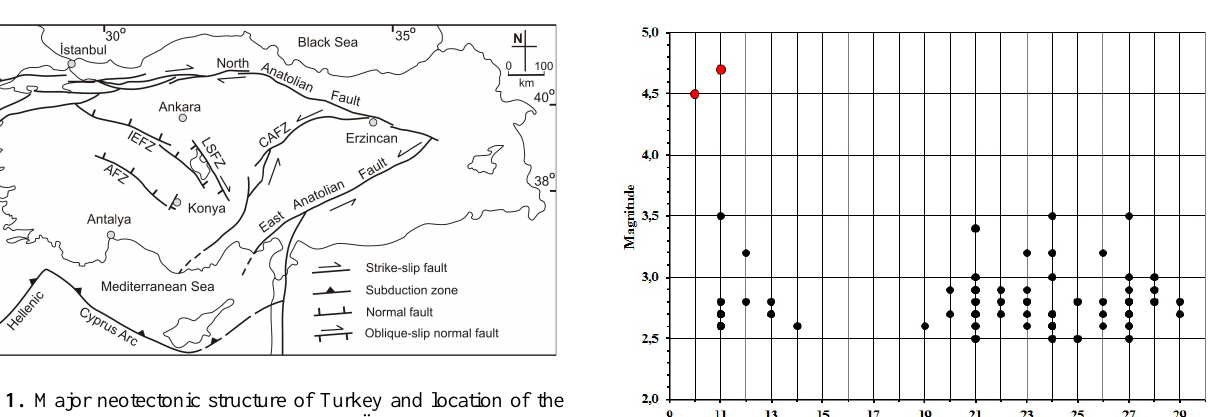
Fig. 1. Major neotectonic structure of Turkey and location of the study area (simplified after Koc¸yi˘git and ¨Ozacar, 2003). AFZ, Aks¸ehir Fault Zone; CAFZ, Central Anatolian Fault Zone; IEFZ, ˙In¨on¨u-Eskis¸ehir Fault Zone; LSFZ, Lake Salt Fault Zone. 2 The Konya city